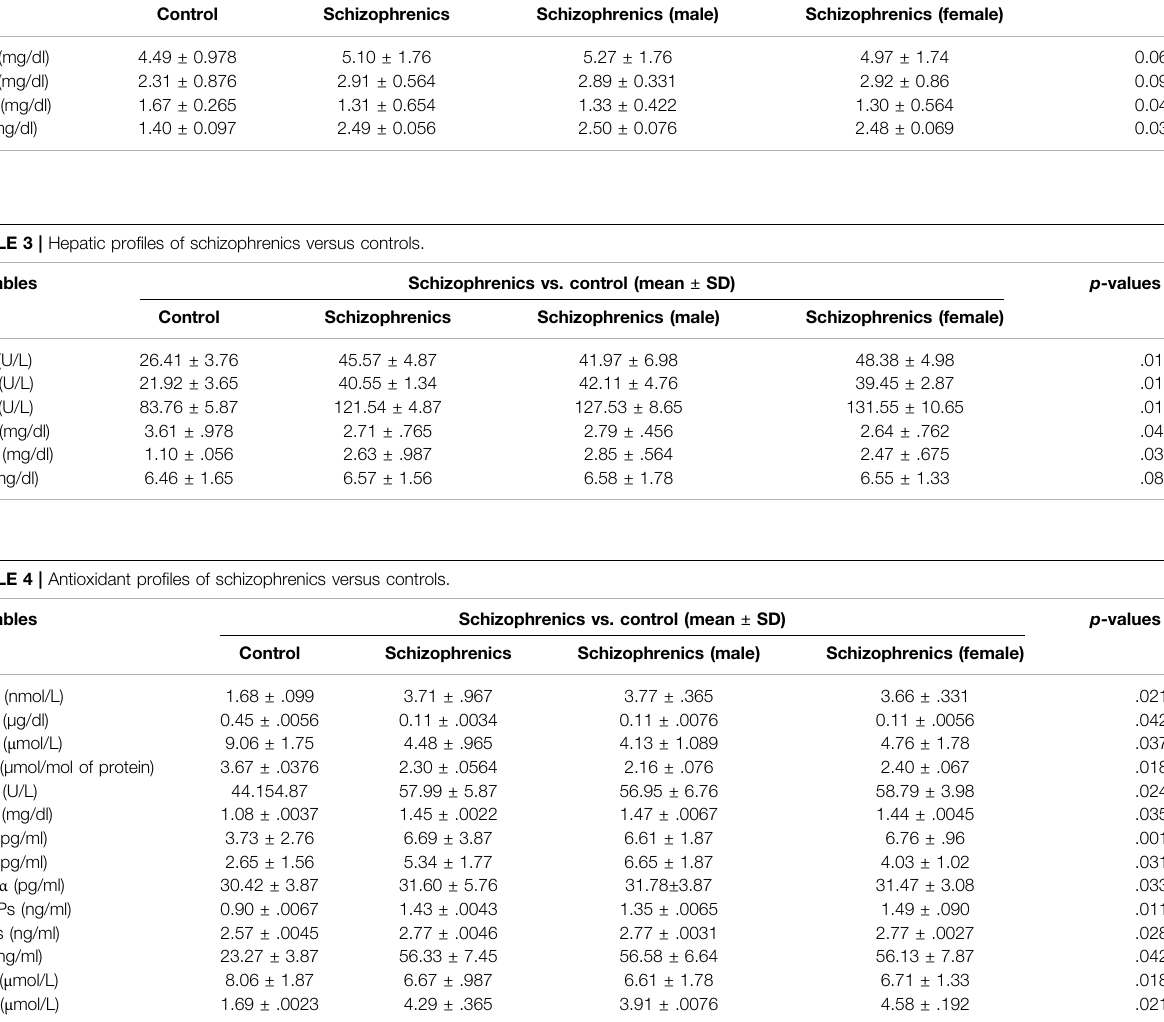
TABLE 2 | Lipid pro fi les of schizophrenics versus controls. Variables